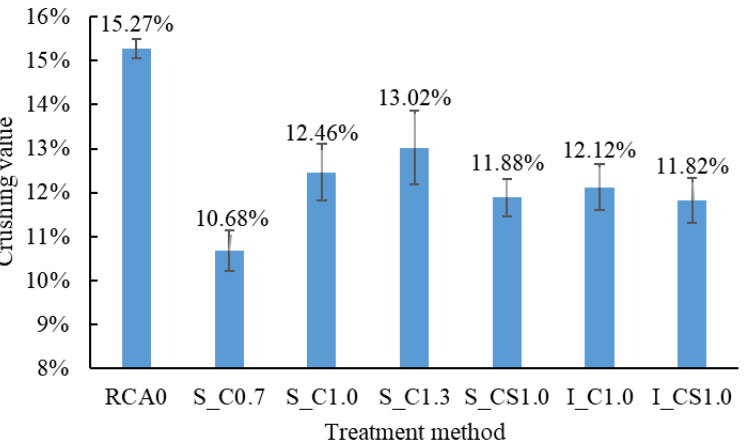
Figure 11. The CV of the RCA with different treatment methods.